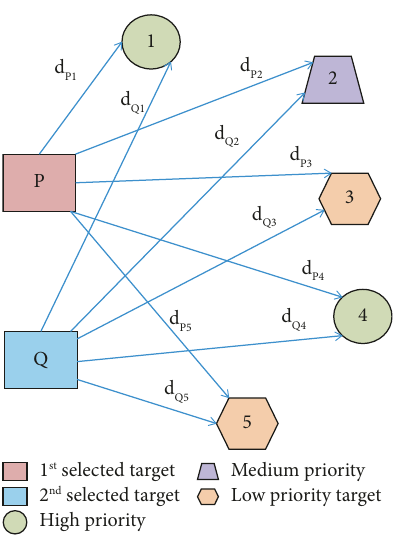
Figure 6: Proposed layout showing distances of targets from first and second selected